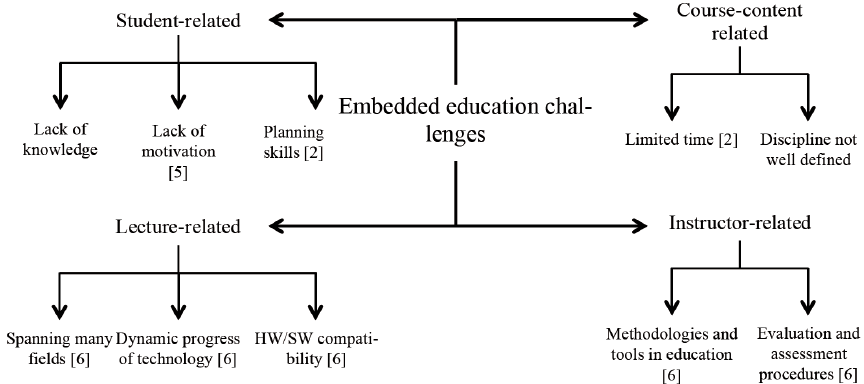
Fig. 1. Embedded education